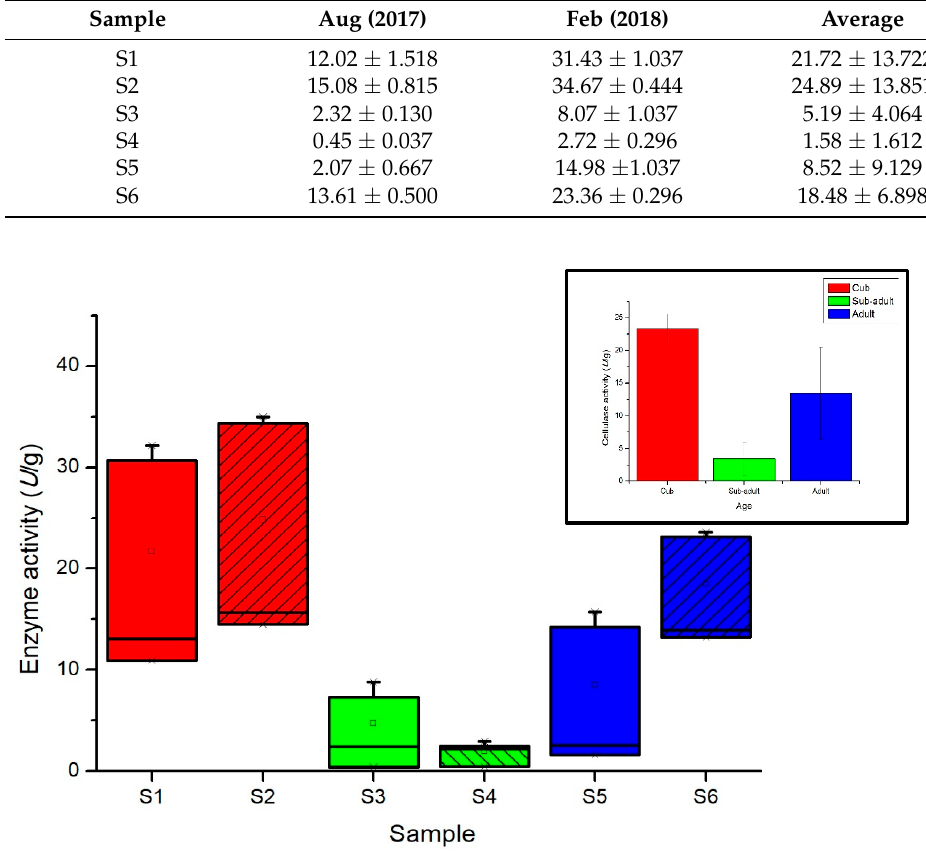
Figure 6. Intestine cellulase activity (the values corresponding to average ± standard deviation) of giant panda at different developmental stages. Take the average of two experimental results in Aug (2017) and Feb (2018) of each sample.